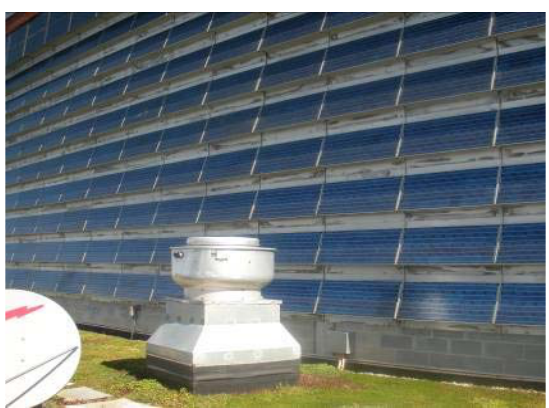
Figure 3. The Solaire’s bulkhead